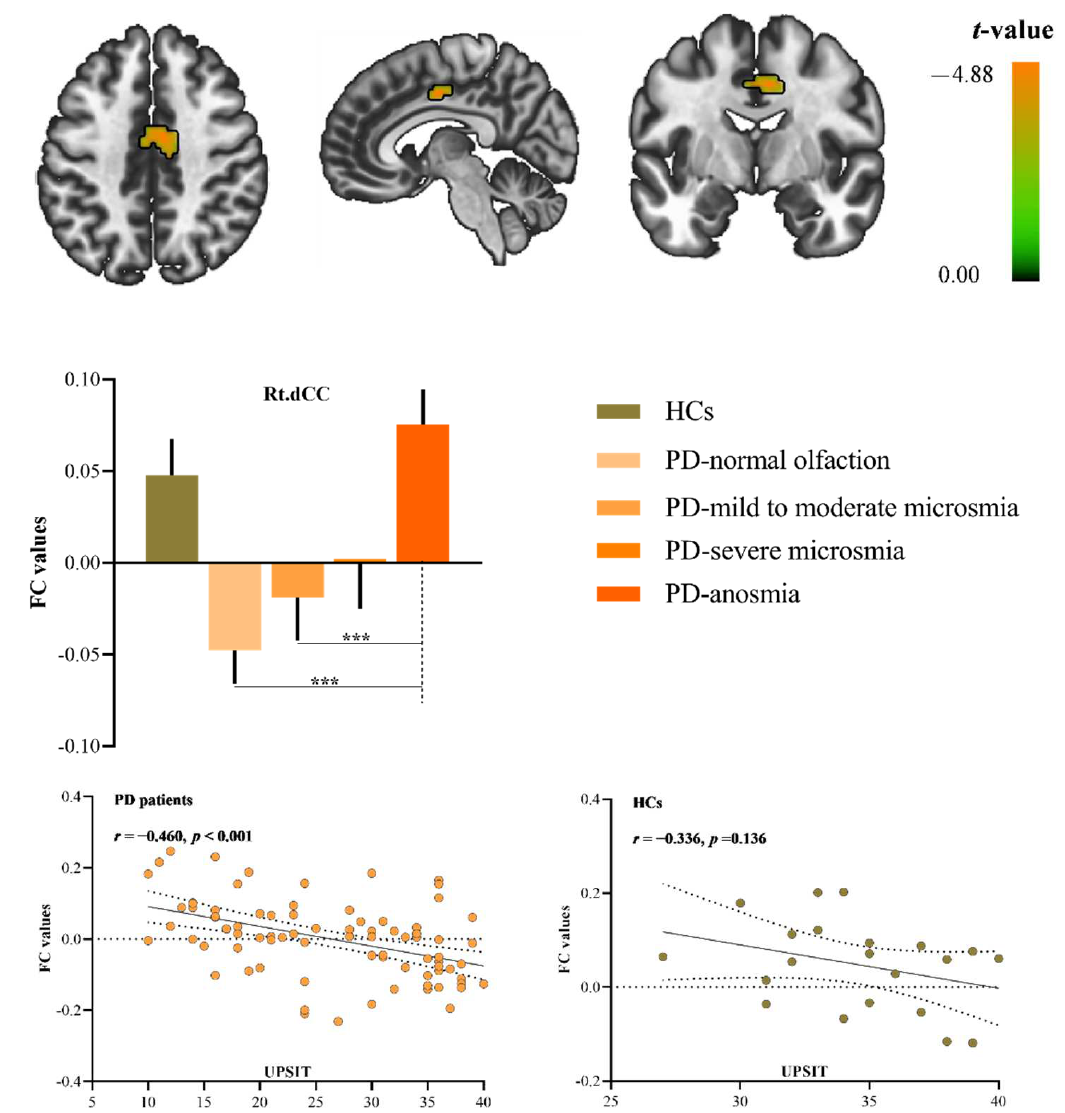
Figure 1. A significantly negative correlation between the olfactory performance and the FC of the EC. The scatterplots indicate a negative correlation between FC of the left EC-right dCC and UPSIT scores in all PD patients. The bar chart shows the FC of the left EC-right dCC values in the five groups. Note: The results were thresholded based on an uncorrected voxel-wise height threshold of p < 0.001 combined with an FWE-corrected cluster-wise threshold of p < 0.05. Post hoc comparisons were performed using two-sample t -tests to determine group differences in the extracted FC values.